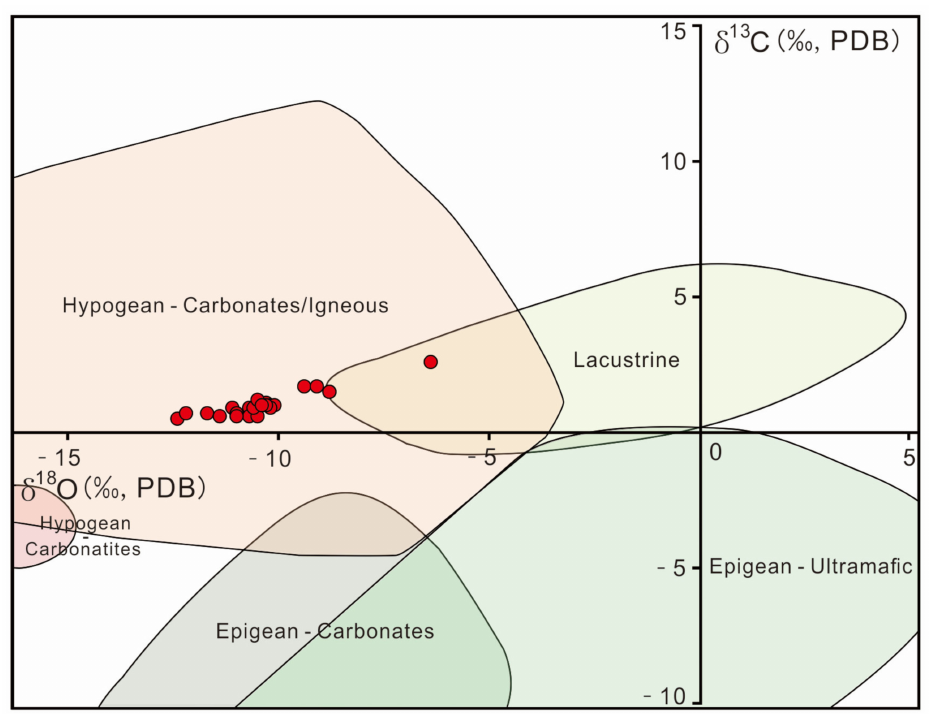
Figure 7. Results of stable isotopes overlain on clusters. All dots plotted within hypogean travertine area of Teboul et al. [60], with CO 2 derived from carbonates or an igneous